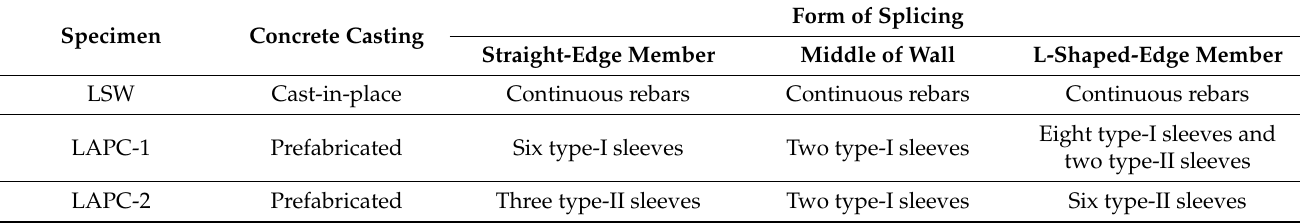
Table 1. Casting method of the specimen and splicing form of the longitudinal